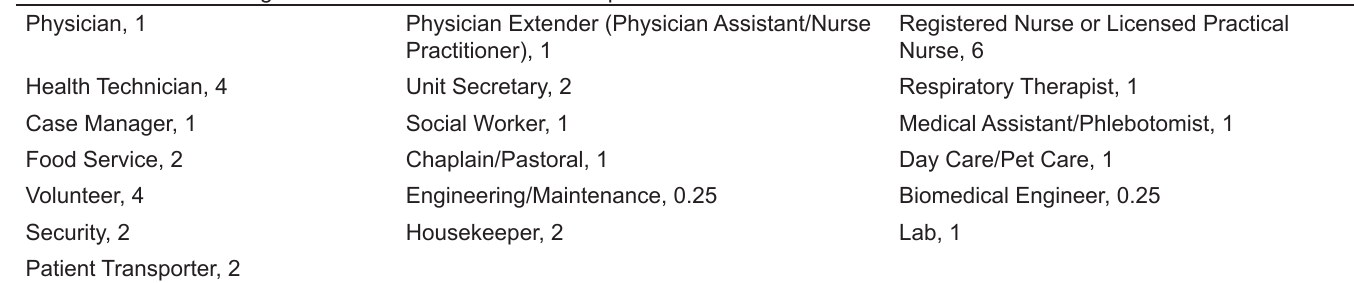
Table 4. Idealized staffing for a 50-bed alternative care site per 12-hour shift. 6,7